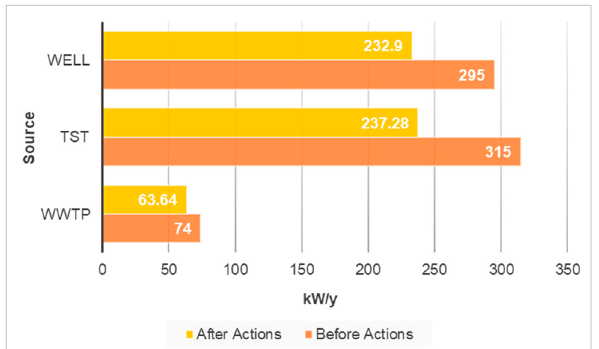
Figure 5. Annual consumption by source (kW). Source: Own elaboration .